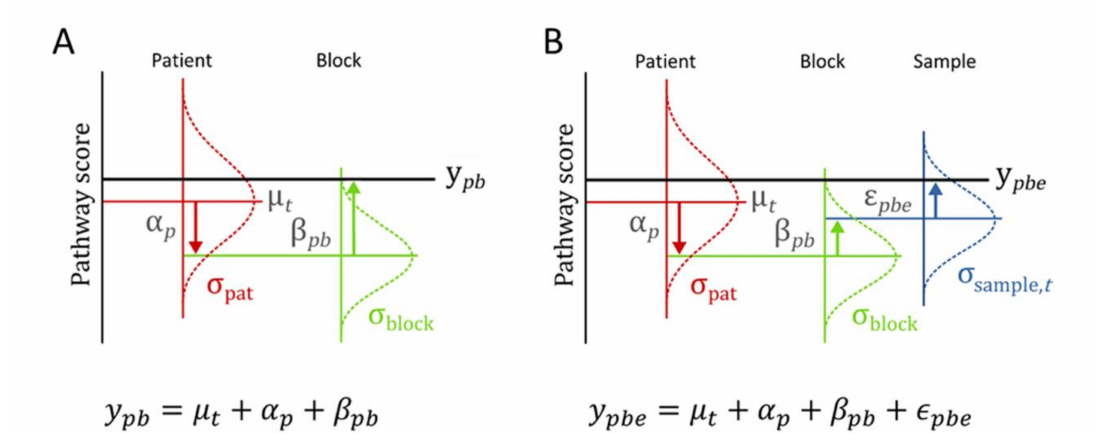
Figure 2. Schematic representation of models used for data analysis. ( A ) Model used for estimation of variation in signaling pathway activity between breast cancer subtypes (y pq = µ t + α p + β pq ) . ( B ) Extended model enabling additional comparison between variation at micro-scale and macro-scale. (y pqe = µ t + α p + β pq + ε pqe ) . The models have random contributions that are added to each other; the random character of each level of contribution is indicated by a Gaussian distribution with standard deviation ( σ ) and example realizations from that distribution. The models describe the pathway activity scores y pb and y pbe as a sum of contributions. Starting from the average score µ t (computed for each breast cancer subtype t separately, with t being Luminal A, Luminal B, or ER negative), a patient-specific contribution α p (red arrows) and a block-specific contribution β pb (green arrows) are added to the average signaling pathway activity score ( µ t ). In the extended model, an additional contribution ε pbe (blue arrow) is added to the pathway activity score of each block, to model the possibility of quadrant-to-quadrant heterogeneity (see Figure 1B for block and quadrant